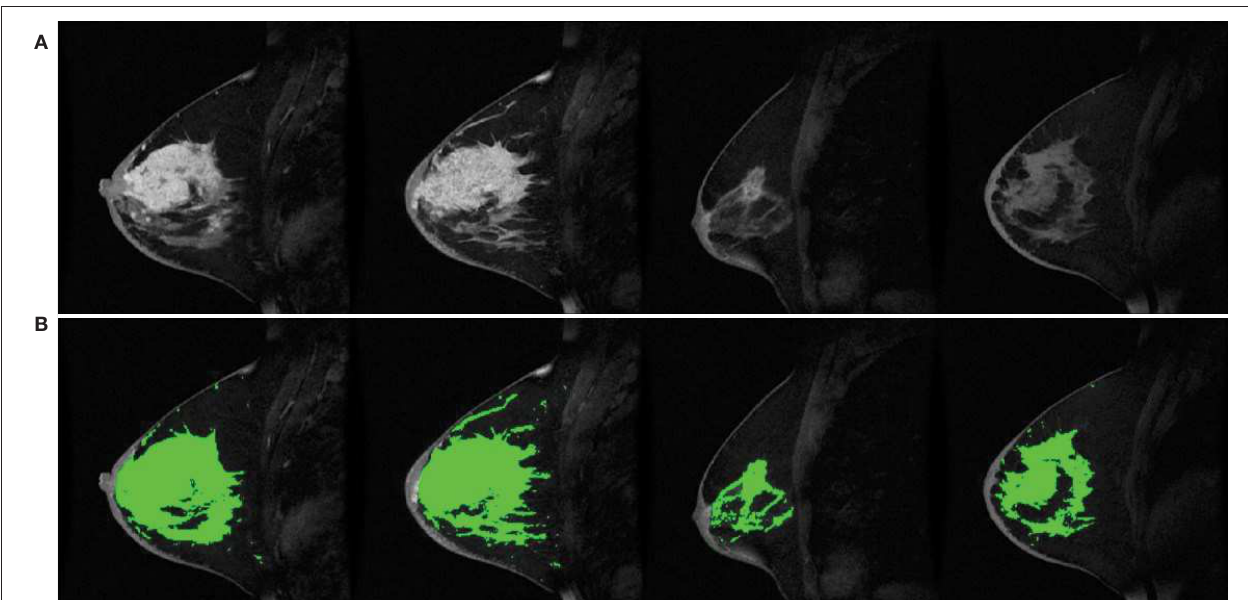
FIGURE 2 | High-resolution 1.5T DCE MRI of four subjects from the American College of Radiology Imaging Network (ACRIN) 6657 repository (31) (A) unmodified and (B) with the segmented breast fibroglandular tissue overlaid in green.